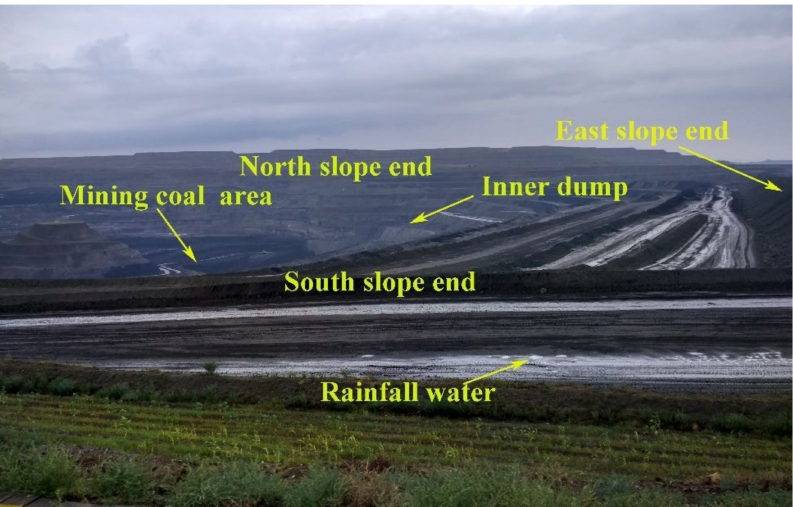
Figure 11. Field view of the inner dump